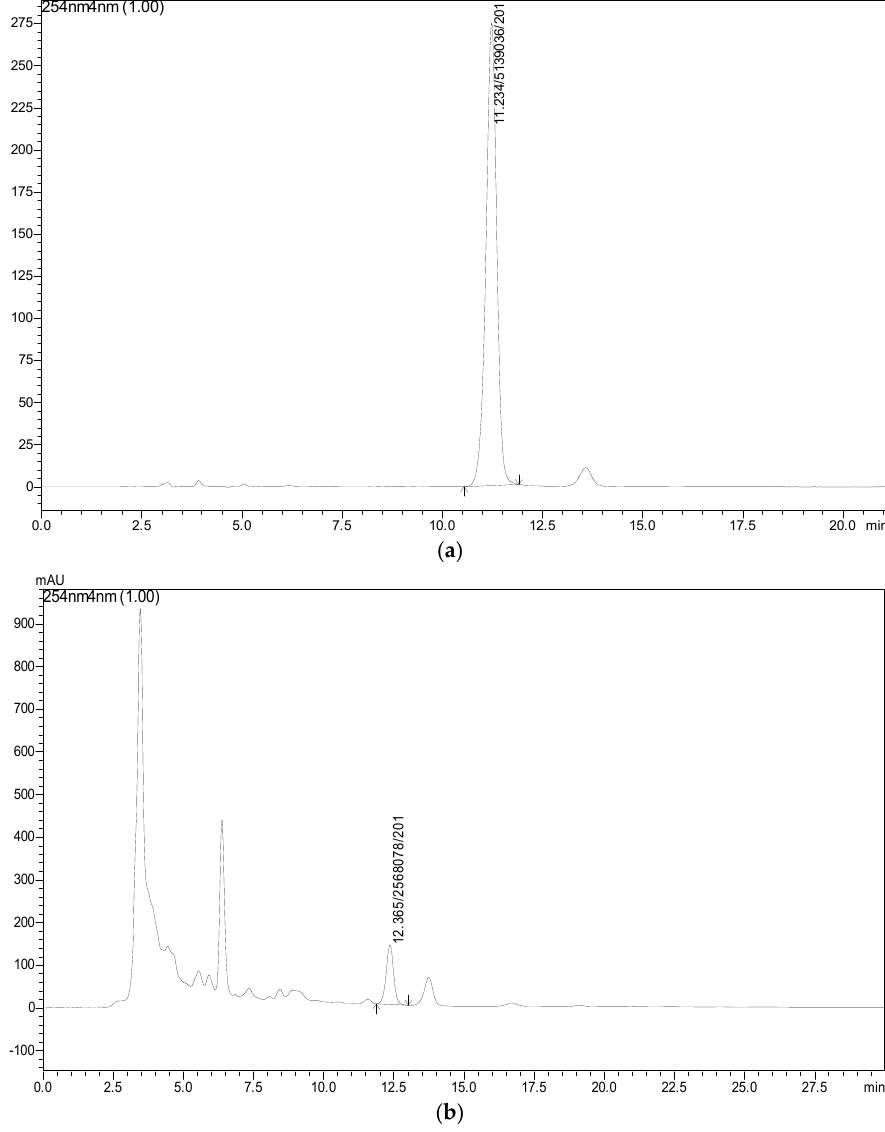
Figure 2. RP-HPLC chromatograms for standard emodin ( a ) and PHELA ® extract ( b ).